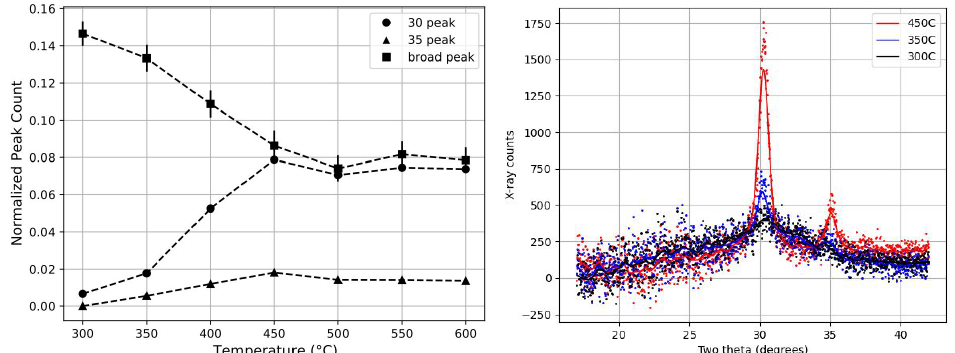
Figure 3. The plot on the left shows that the normalized peak-counts (defined in the text) for the crystallization and amorphous components are shown as a function of the annealing temperature for the sample with 14 layers × 14.4nm of zirconia. This demonstrates the increase in crystallization at the expense of the amorphous material without reaching the full crystallization of the available zirconia. The plot on the right demonstrates the evolution of the XRD data after annealing.